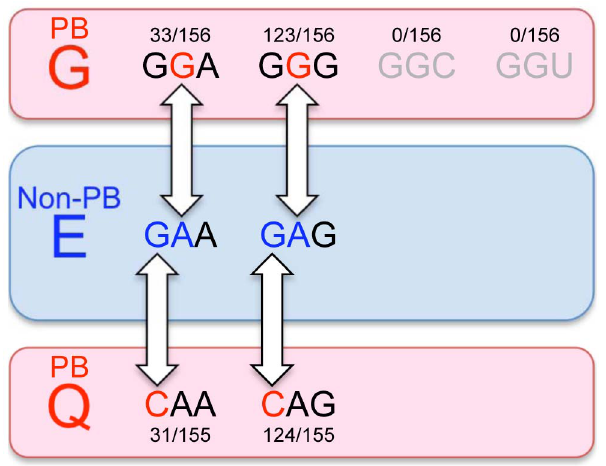
Figure 6. The evolution of EV71-PB and EV71-non-PB . The amino acids at VP1-145 and their codons are shown. The numbers above or below the codons indicate their frequency in GenBank. EV71 with VP1- 145G or VP1-145Q are the PSGL-1-binding (PB) phenotype and the minor populations in GenBank (red round rectangles). EV71 with VP1- 145E is the PSGL-1-nonbinding (non-PB) phenotype and the major population in GenBank (blue round rectangles). The phenotypic change between PSGL-1-binding and PSGL-1-nonbinding can occur easily, because only one nucleotide substitution changes amino acid (white arrows). The amino acid change between G and Q would not occur easily, as their codons have two nucleotide differences. Neither GGC nor GGU was found to encode VP1-145G in